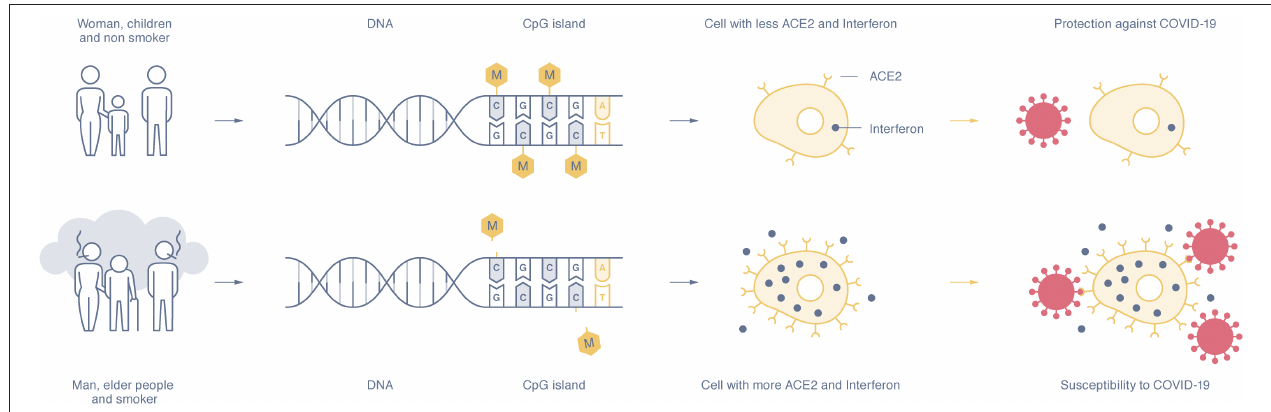
FIGURE 1 | The expression of the ACE2 and interferon gene depends on the methylation rate of the CpG islands in the DNA promotor sequence. Susceptible individuals, mostly men, the elderly, and smokers, show a hypomethylation pattern of the ACE2 and interferon genes (lower part), whereas women, children, and non-smokers show DNA hypermethylation and lower expression of ACE2 and interferon proteins (upper part). The higher presence of ACE2 on epithelial cells and interferon makes people more susceptible to SARS-CoV-2 infection and increases disease severity, whereas a low presence of ACE2 and interferon seems to offer disease